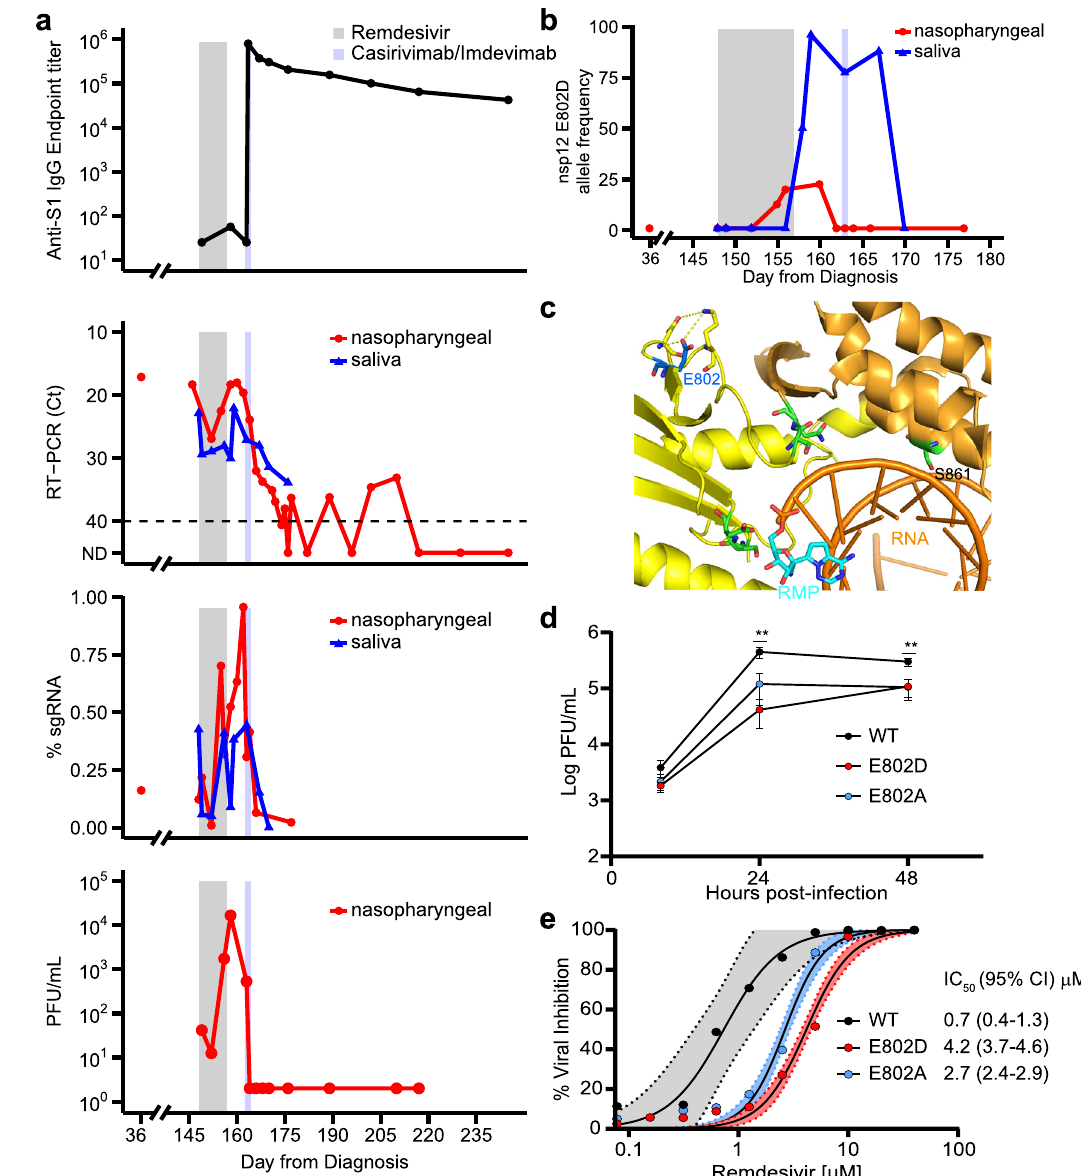
Fig. 2 De novo emergence of remdesivir resistance mutation during and following treatment with the antiviral agent. a Anti-SARS-CoV-2 Spike Protein IgG ELISA endpoint titers (1st panel), RT-PCR Ct values (2nd panel), subgenomic RNA (sgRNA, 3rd panel), and plaque forming units (PFU) on viral culture (4th panel) during the course of illness which include the period when remdesivir (gray shading) and casirivimab/imdevimab (light blue shading) were administered. b Allele frequencies of E802D in nsp12 as ascertained by whole genome sequencing. c Crystal structure (PDB:7BV2) depicting nsp12 E802 (dark blue), its putative hydrogen bonds (yellow dashed lines) within the palm domain (yellow), and the residues (green) that interact with the replicating RNA molecule (orange). Remdesivir monophosphate (RMP) is depicted in light blue. d Viral growth curves from icSARS-CoV-2 mNG WT, E802D (patient), and E802A (control) nsp12 mutants on a ORF7a depleted backbone. Results are depicted as mean and standard deviation (error bars) of data from biological replicates ( n = 3). Signi fi cance between WT and E802D mutants was assessed by unpaired, two-sample t tests, ** p < 0.01 ( p = 0.002 at 24 h, p = 0.006 at 48 h). e SARS-CoV-2 inhibition by RDV assessed at 48 h post-infection (0.01 multiplicity of infection) as determined by quantitative image analysis of percentage of cells expressing mNG. Color-coded curves represent a non-linear least squares fi t of biological replicates ( n = 3) and shading represents 95% con fi dence intervals of the fi t. Figure is representative of four biological